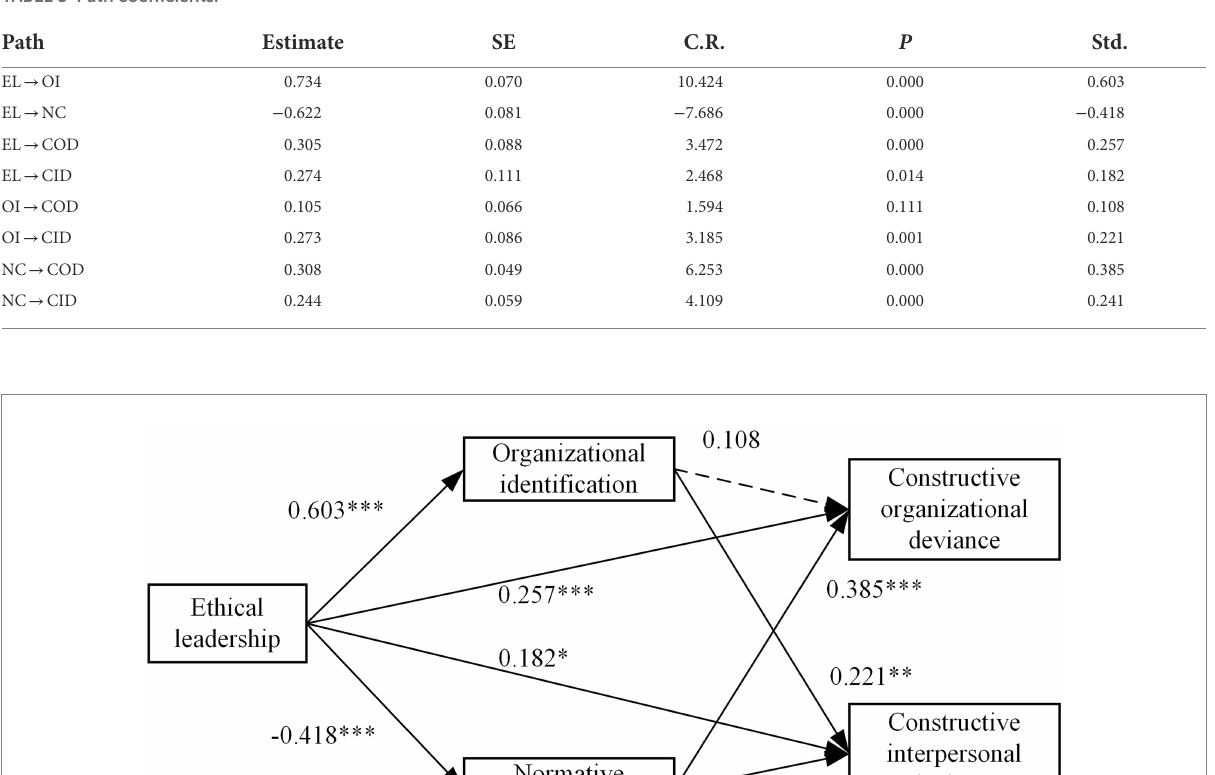
TABLE 5 Path coefficients.